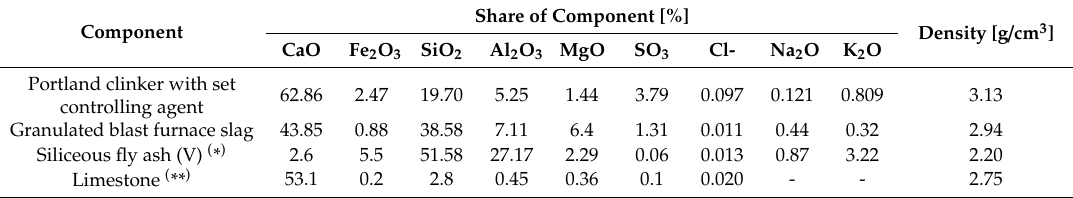
Table 2. Chemical composition and physical properties of main cement components.